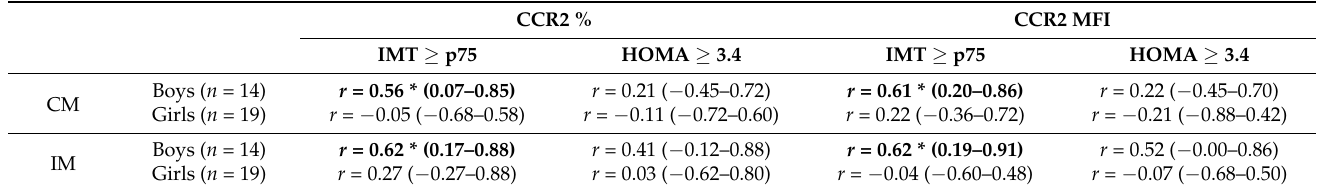
Table 2. Correlation of monocyte subsets expressing CCR2 with IMT and HOMA in boys and girls with